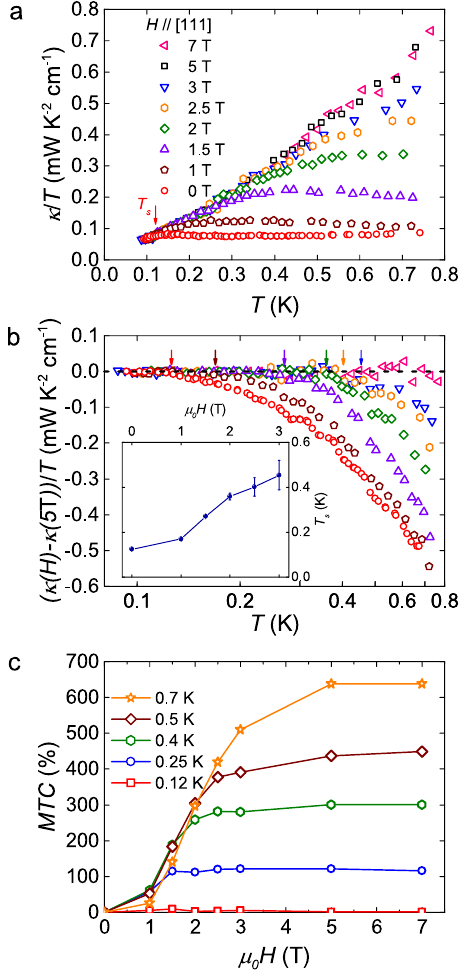
Fig. 2 Heat transport results of Pr 2 Ir 2 O 7 . a The thermal conductivity of Pr 2 Ir 2 O 7 single crystal at various magnetic fi elds along the [111] direction. At zero fi eld, the thermal conductivity is strongly suppressed above T s ≈ 0.12 K. b The data of thermal conductivity in ( a ) after subtracting the data of 5 T. A collapse region is clearly shown below the temperature at which the arrows point. This suppression temperature is de fi ned as T s . Inset: fi eld dependence of the suppression temperature T s . The error bars re fl ect the uncertainty in determining the temperature above which the data deviate from 0. They are estimated as the possible suppression temperature range due to the discrete data points. c The magneto-thermal conductivity MTC = ( κ ( H ) − κ (0 T))/ κ (0 T) × 100% at various temperatures. Above 5 T, the thermal conductivity tends to saturate.